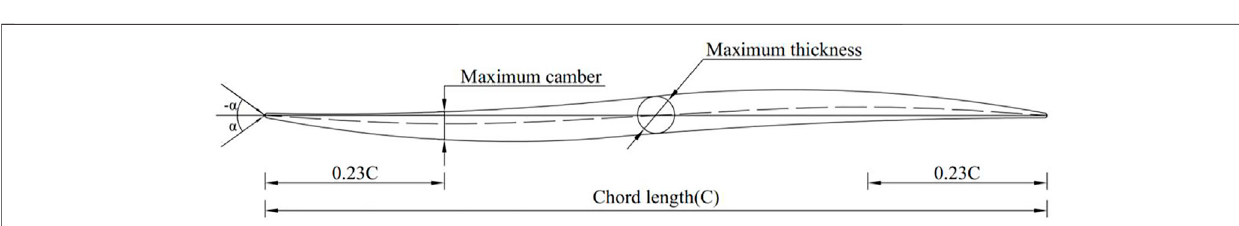
of attack for positive lift corresponds to a lower drag value. For further comparison in this paper, the suction surface and pressure surface shown in Figure 2 are de fi ned uniformly.